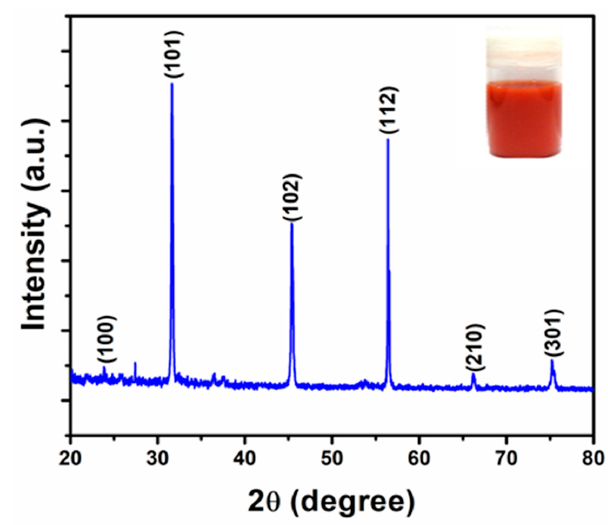
Figure 3. XRD pattern of the prepared SeNPs.